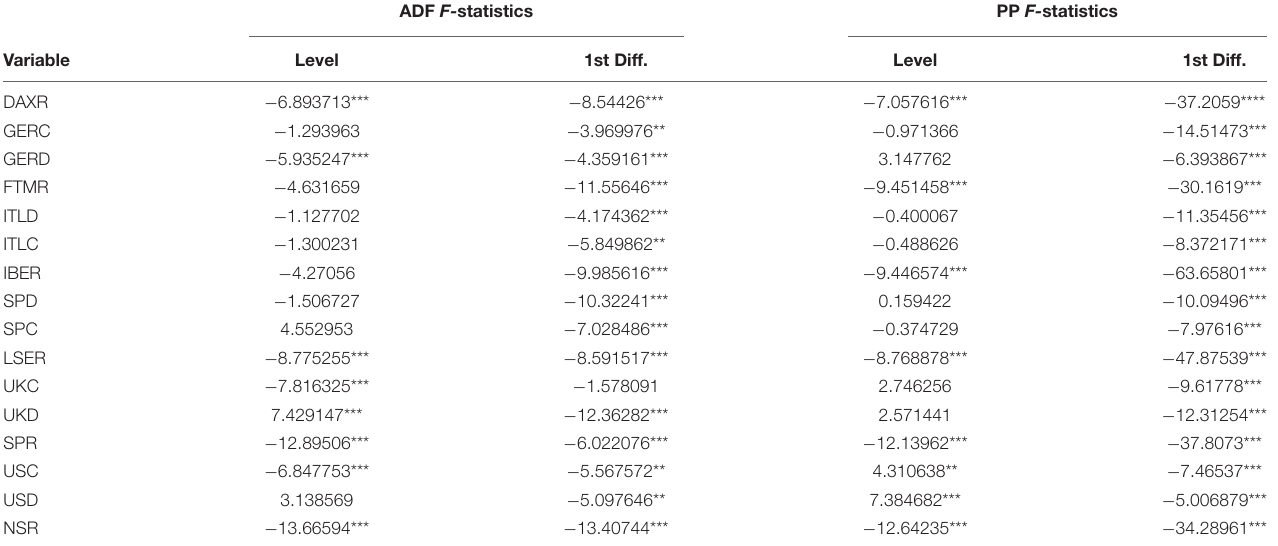
TABLE 2 | Unit root